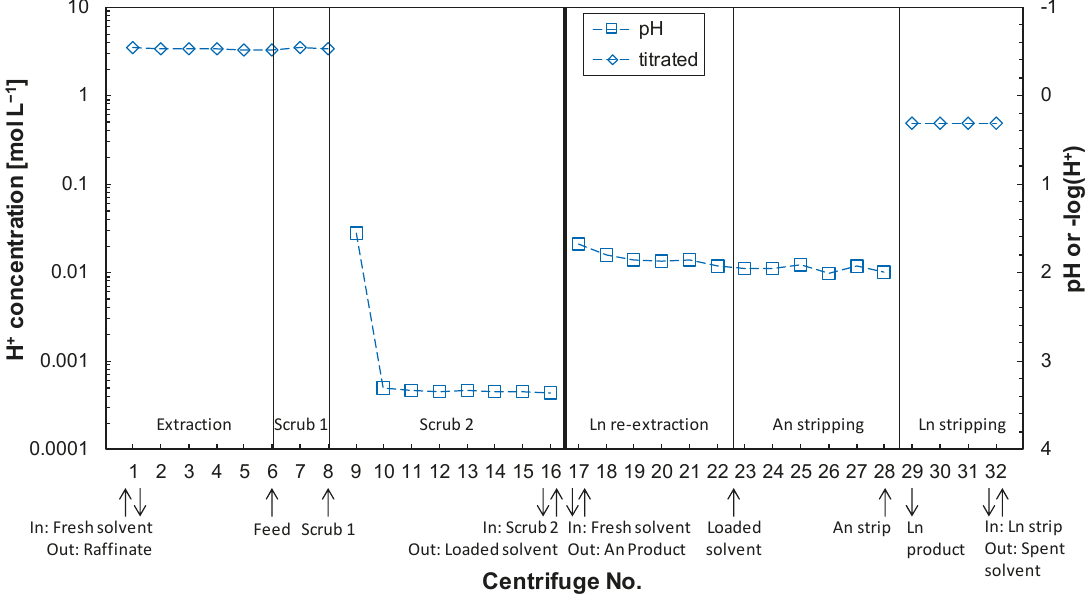
Figure 9. Measured pH values or titrated H + concentration in the stages of the ALSEP demonstration test. Note that the right y-axis is plotted upside